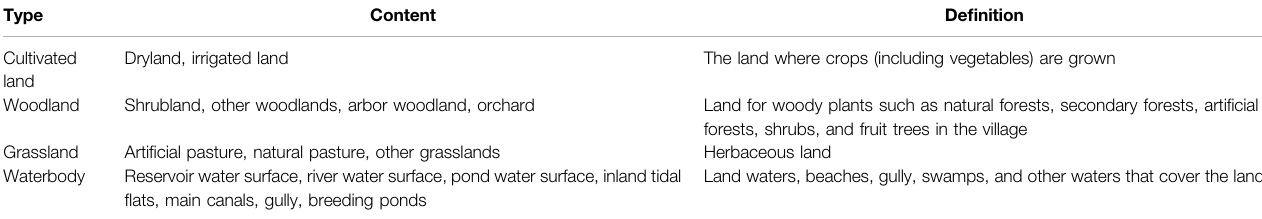
TABLE 1 | Classi fi cation and de fi nition of EL types. Type Content De fi